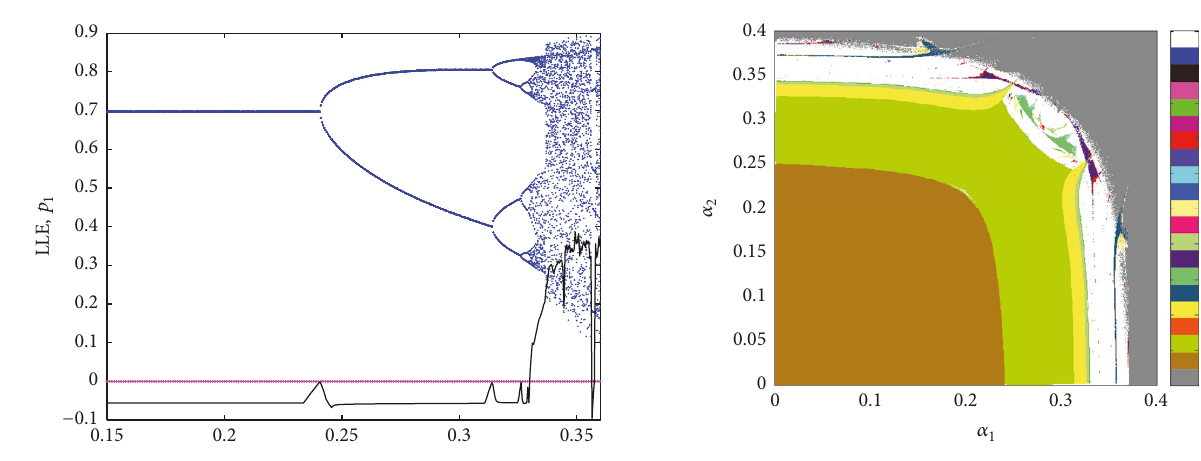
Figure 8: Parameter basin in (𝛼 1 , 𝛼 2 ) plane when 𝜃 = 0.6 , 𝛼 = 0.5 , and 𝑤 𝑖 = 1 .